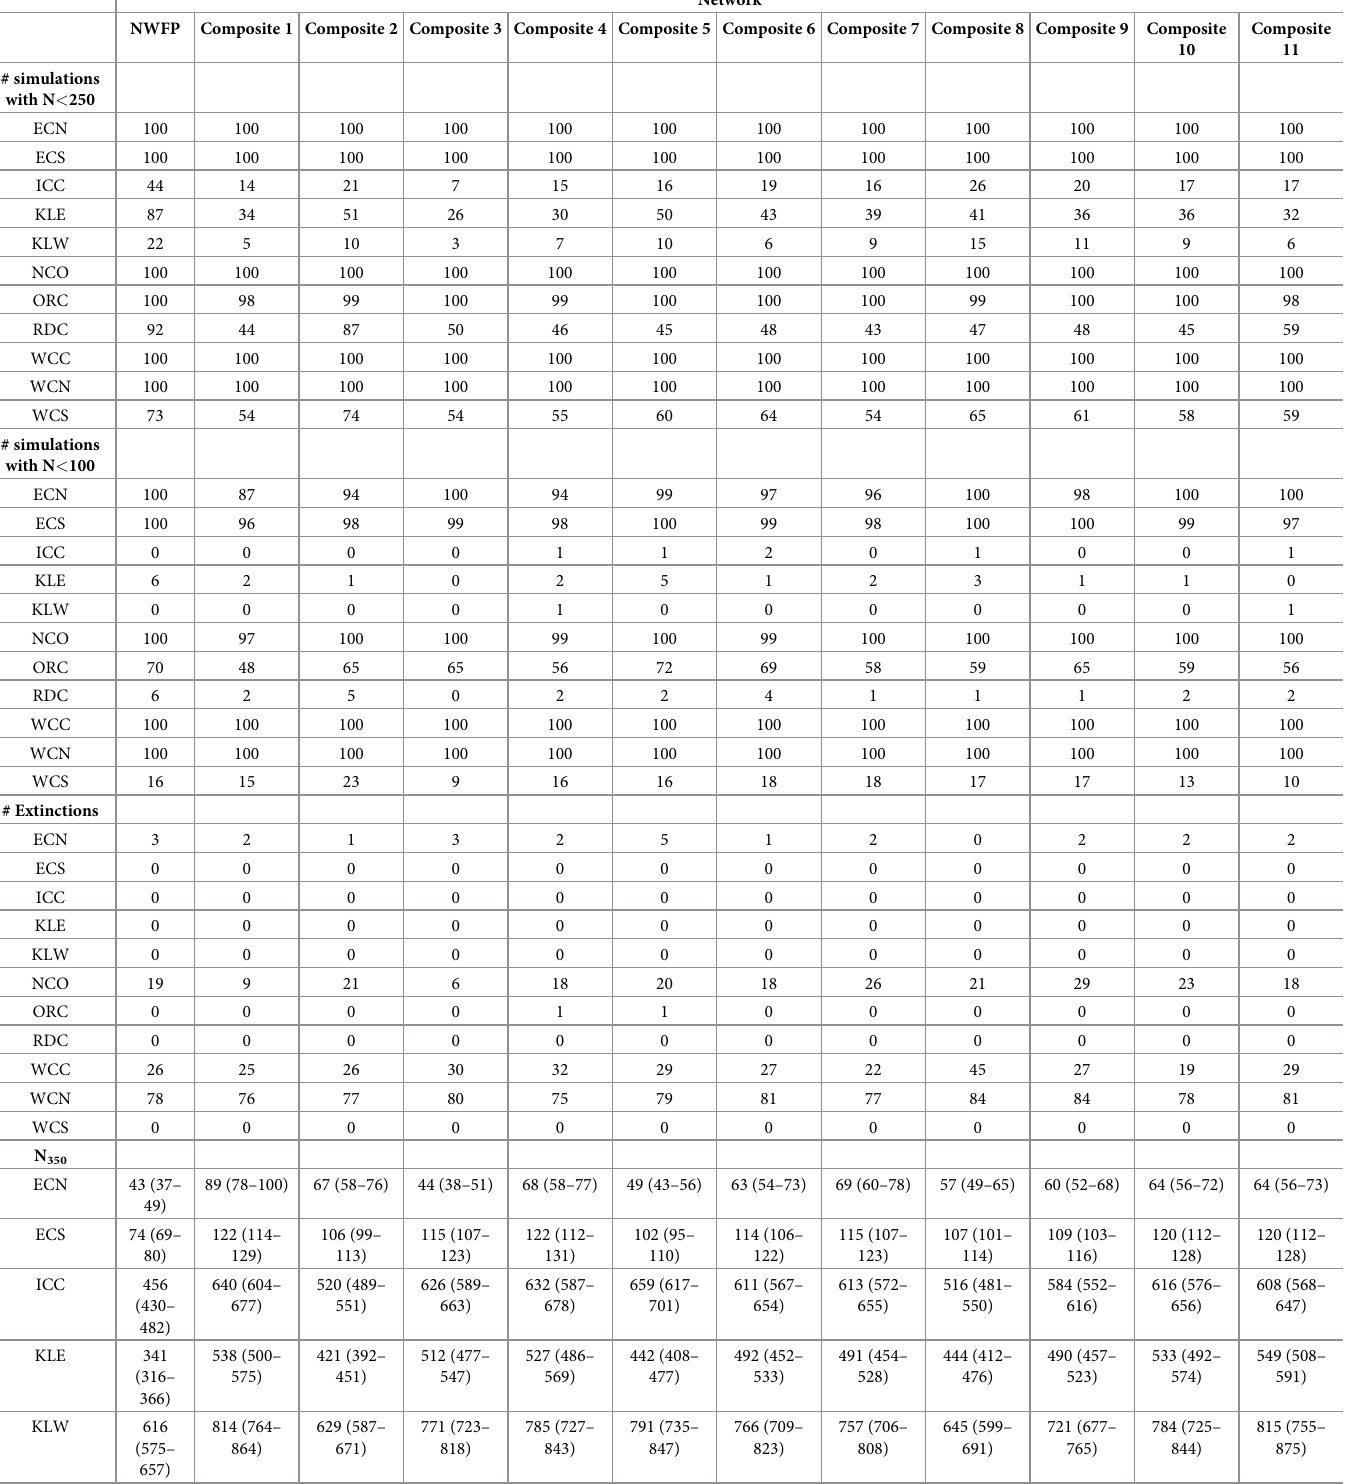
Table 12. Estimated northern spotted owl population responses, in modeling regions, to potential critical habitat networks for the pessimistic relative habitat suit- ability change scenarios.